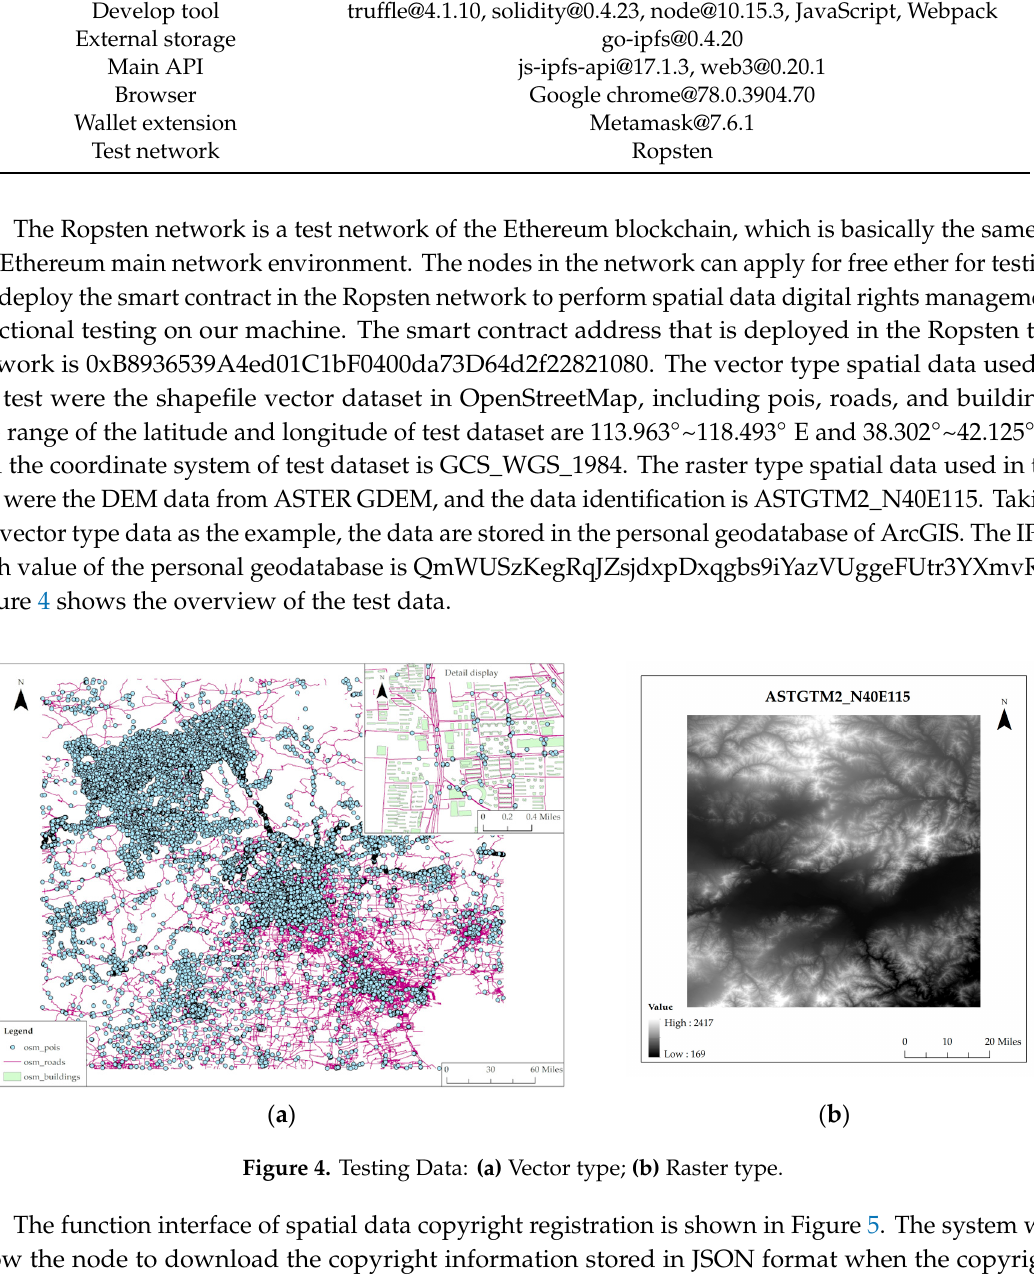
Figure 5. Copyright registration interface. Table 5. Copyright information for sample data. Field Value Spatial Data ID